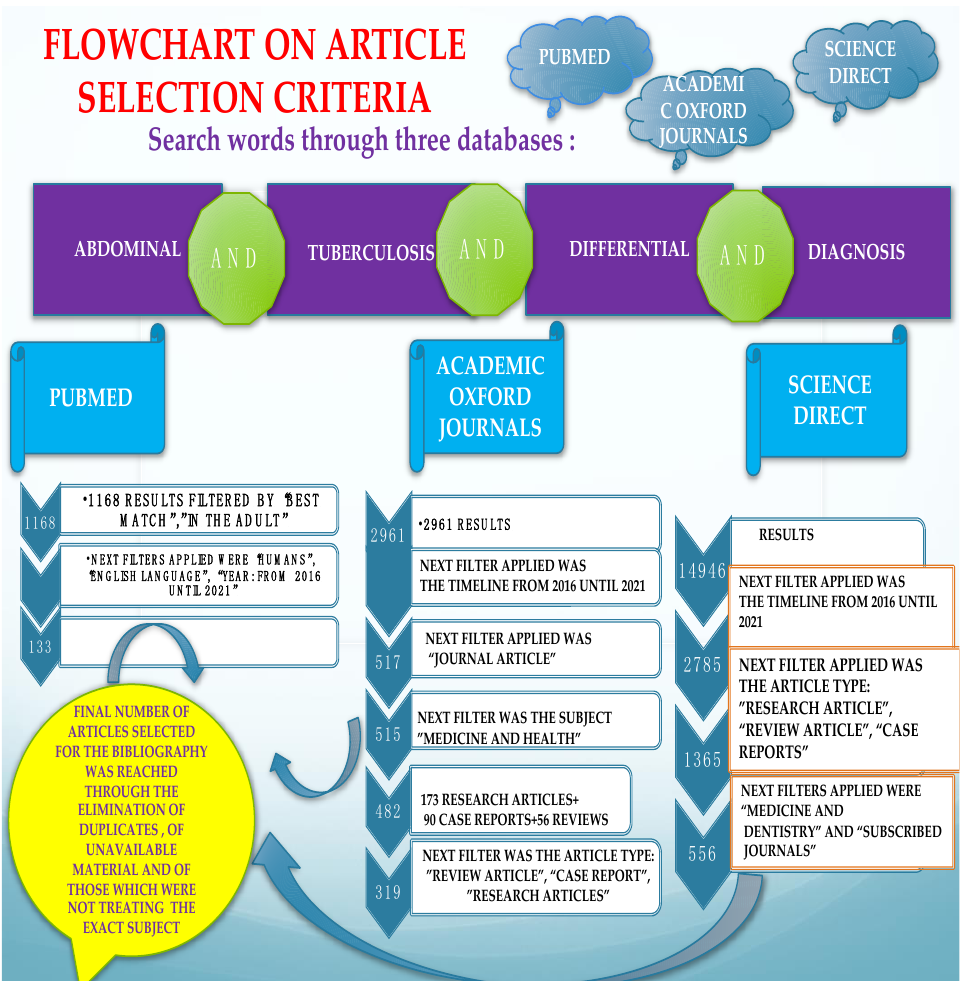
Figure 1. Flowchart illustrating the selection criteria employed in the current review. Table 1. List of countries, depicting the number of articles found during the search and grouped